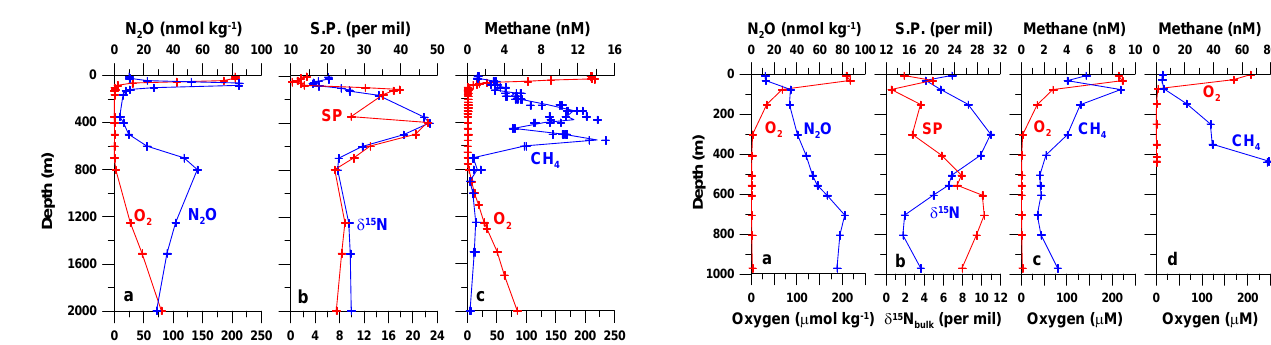
Fig. 6. (a–c) Vertical profiles of dissolved O 2 , N 2 O and CH 4 con- centrations, δ 15 N of N 2 O and SP of 15 N in N 2 O at an open margin Fig. 5. Vertical profiles of dissolved O 2 , N 2 O and CH 4 concentra- station in the Gulf of California (26.3 ◦ N, 110.13 ◦ W); (d) Vertical tions, δ 15 N of N 2 O and Site Preference (SP) of 15 N in N 2 O at a profiles of dissolved O 2 and CH 4 at a silled-basin station (sill depth station located within the open-ocean suboxic zone of the eastern 50m) in the same region (21.3 ◦ N, 105.9 ◦ W). Data are from San- tropical North Pacific (16 ◦ N, 107 ◦ W). Data are from Sansone et sone et al. (2001, 2004) for CH 4 and from Yamagishi et al. (2007) al. (2001) for CH 4 and from Yamagishi et al. (2007) for N 2 O. for N 2 lower boundary of the OMZ had lower CH 4 concentrations Fig. 5 than the station where the OMZ impinged upon the seafloor, consistent with higher CH 4 supply to and/or lower oxidative loss within the OMZ. The highest build-up of CH 4 (up to 78 nM) was found to occur in bottom waters of silled basins (Fig. 6d), presumably through diffusion from the seafloor.